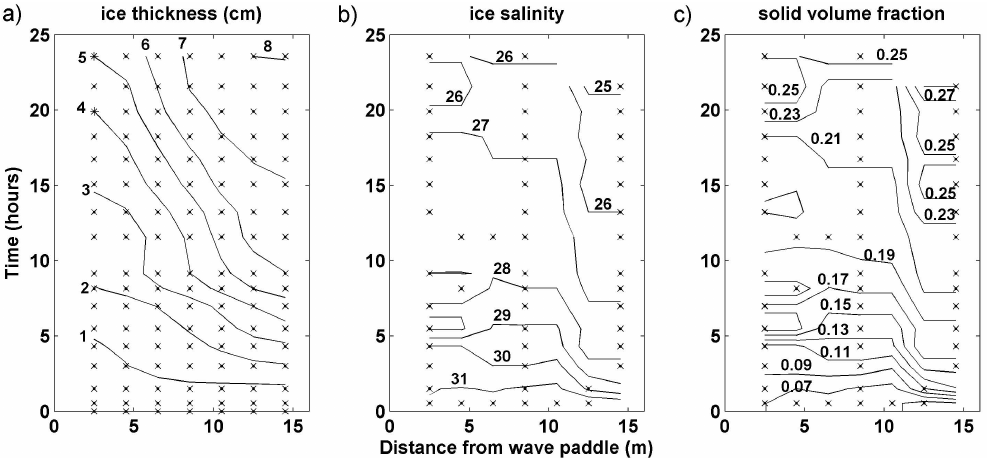
Fig. 4. Contour plot of thickness, salinity and solid fraction for experiment E1, averaging observations from tanks A and B. Crosses indicate the observation locations and